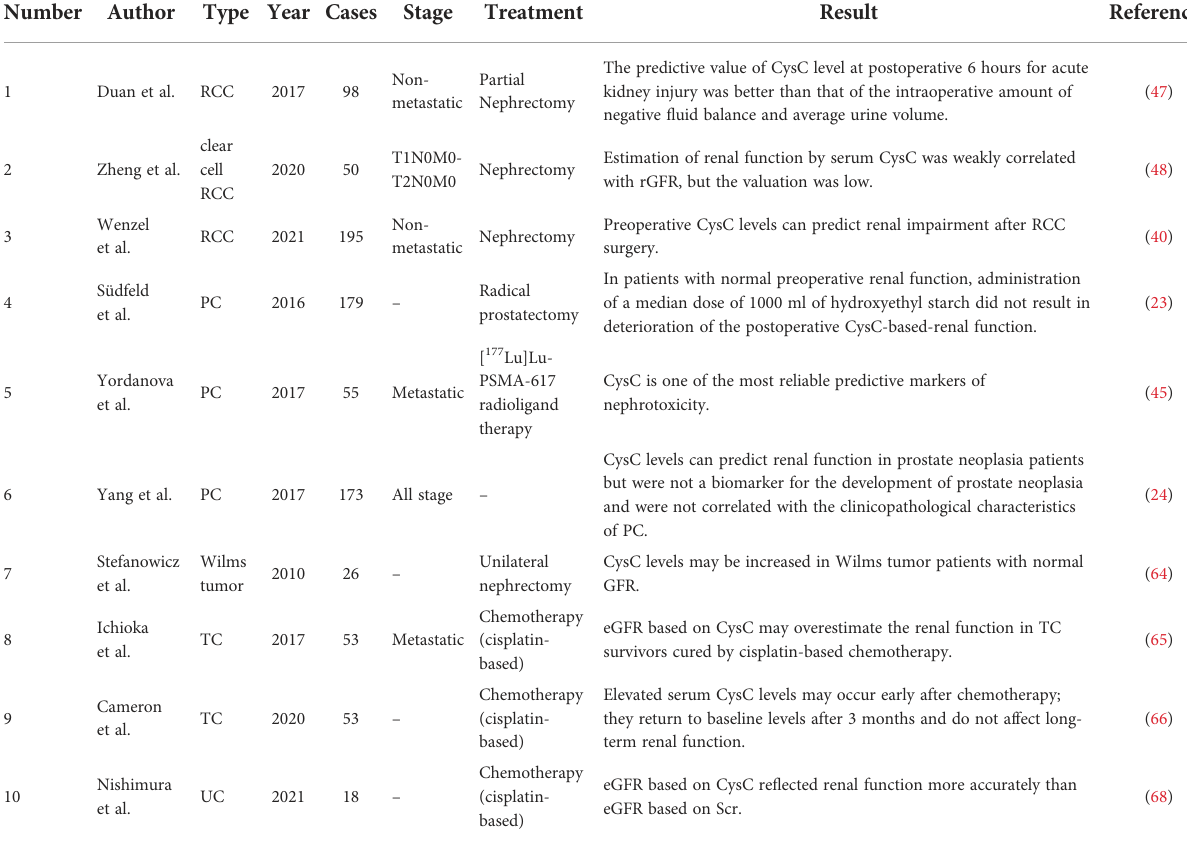
TABLE 1 Overview of studies in the relationship between pretreatment serum cystatin C level and renal function in patients with urogenital